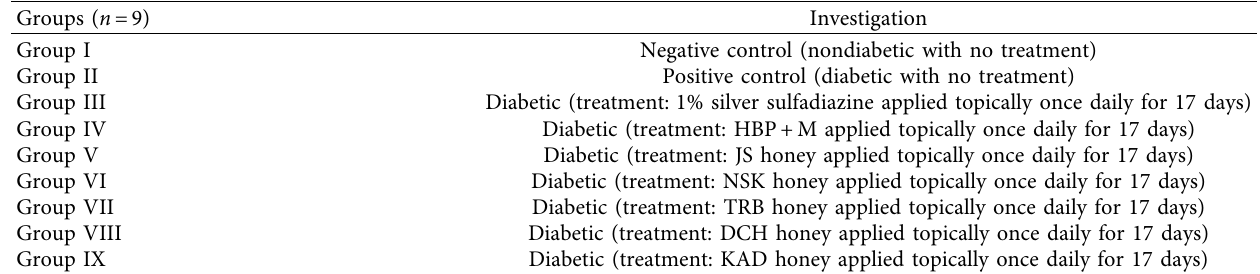
Table 1: List of experimental